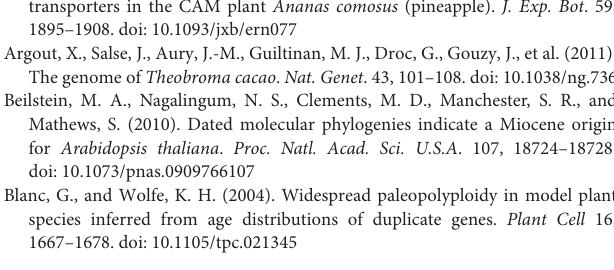
Supplementary Figure 1 | The linear correlation of the number of tandem duplicated early response to dehydration six-like (ESL). (A) The total number of duplicated ESL with the total number of ESL in each species. (B) The total number of duplicated ESL3 with the total number of ESL in each species. (C) The total number of eudicots duplicated ESL3 with the total number of ESL in each eudicots species. (D) The total number of eudicots duplicated ESL3c with the total number of ESL in each eudicots species. (E) The total number of eudicots duplicated ESL3c with the total number of ESL3 in each eudicots species. Supplementary Figure 2 | Brassicaceae and monocot ESL gene structures. Blue rectangles are for exons and lines are for introns. Exons are represented with the same scale and introns with the same length. Red numerals indicate the number of exons. Supplementary Figure 3 | Cis -regulatory elements found in the 1-kb promoter of A. thaliana ESL genes. (A) The distribution of cis -elements according to their specificity. (B) Common motifs found in all analyzed ESL genes. Supplementary Figure 4 | The maximum likelihood phylogeny of monocot ESL sugar transporter proteins and conserved protein motifs. The tree was produced by aligning 67 amino acid ESL sequences identified in 10 species (Spo, Pd, Ph, Pvi, Si, Sb, Bd, Ma, Os, and Zm) using ClustalW and then build using the software Molecular Evolutionary Genetics Analysis (MEGAv10). Jones–Taylor–Thornton (JTT) amino acid substitution model was used and the bootstrap consensus tree was inferred from 1,000 replicates. Motifs were determined by using MEME. Supplementary Figure 5 | The maximum likelihood phylogeny of Brassicales ESL sugar transporter proteins and conserved protein motifs. The tree was produced by aligning the 126 amino acid ESL sequences identified in 7 species (Ah, Al, At, Br, Cp, Cr, and Th) using ClustalW and then build using the software Molecular Evolutionary Genetics Analysis (MEGAv10). JTT amino acid substitution model was used and the bootstrap consensus tree was inferred from 1,000 replicates. Motifs were determined by using MEME. Supplementary Table 1 | Early response to dehydration six-like (ESL) genes identified in this study. Supplementary Table 2 | Primers used for the expression analysis of AtESL par real-time reverse transcription-PCR (qRT-PCR). Supplementary Table 3 | Number of ESL genes and tandem duplicated ESL identified in this study. Supplementary Table 4 | Unique cis -acting elements identified only in the promoter sequence of a single Arabidopsis thaliana ESL transporter gene. Supplementary Table 5 | Protein motifs identified in the sequence of ESL and other sugar transporters proteins. For one motif, each line represents a single analysis performed with a set of sequences indicated in the last column entitled “Analyzed transporters.” The analysis was performed by using an E -value < E − 60 ; however, a few motifs with a higher E -value are presented as they are specific to ESL group containing few